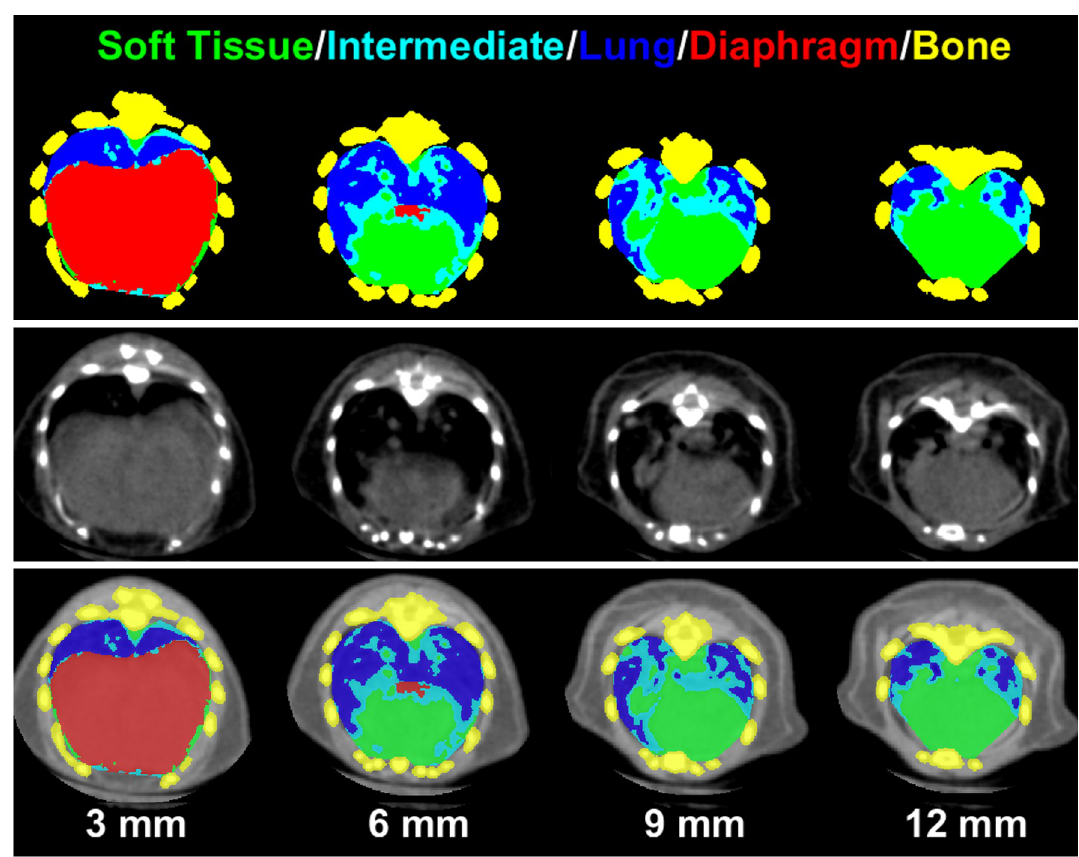
Fig 3. Representative slices of lung from a tumor-bearing mouse showing the resulting segmentation from the MLAST algorithm at various levels (3, 6, 9 and 12 mm) above the base of the diaphragm. Top panel is MLAST only, middle panel is microCT only and the bottom panel is the overlay of MLAST and microCT images. The tissue labels for MLAST segmentation are color-coded for visual purposes: soft tissue (green), intermediate (cyan), lung (blue), diaphragm (red), and the mutlislice bone mask